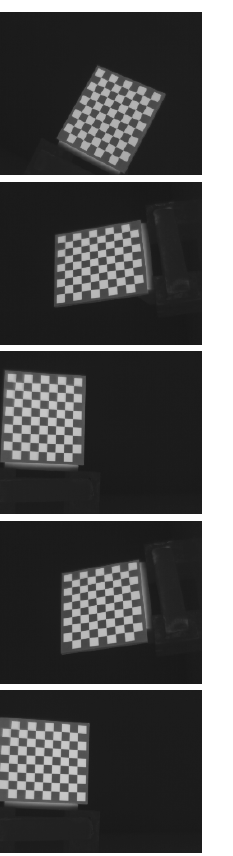
Figure 8. Thermal images of the UV-printed checkerboard pattern viewed at random orientations for the IR camera geometric calibration.